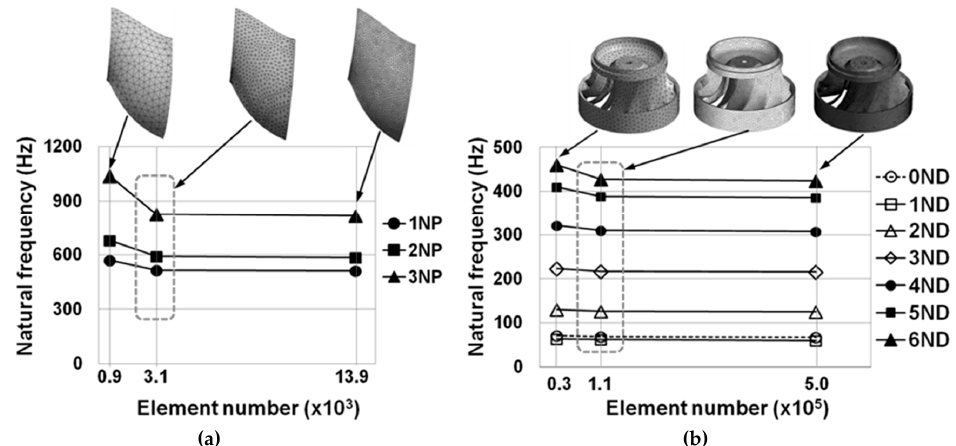
Figure 3. ( a ) Sensitivity analysis of the mesh density for the single blade; ( b ) sensitivity analysis of the mesh density for the entire turbine runner.